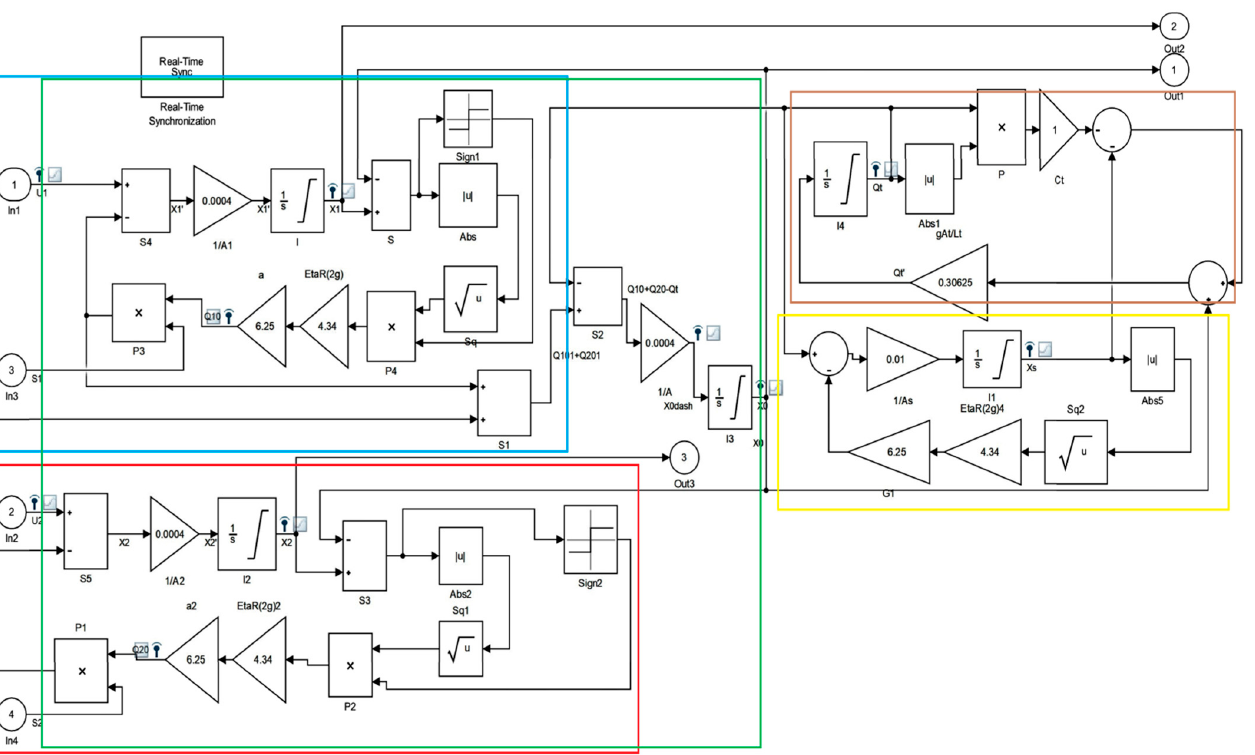
Figure 3. System model in